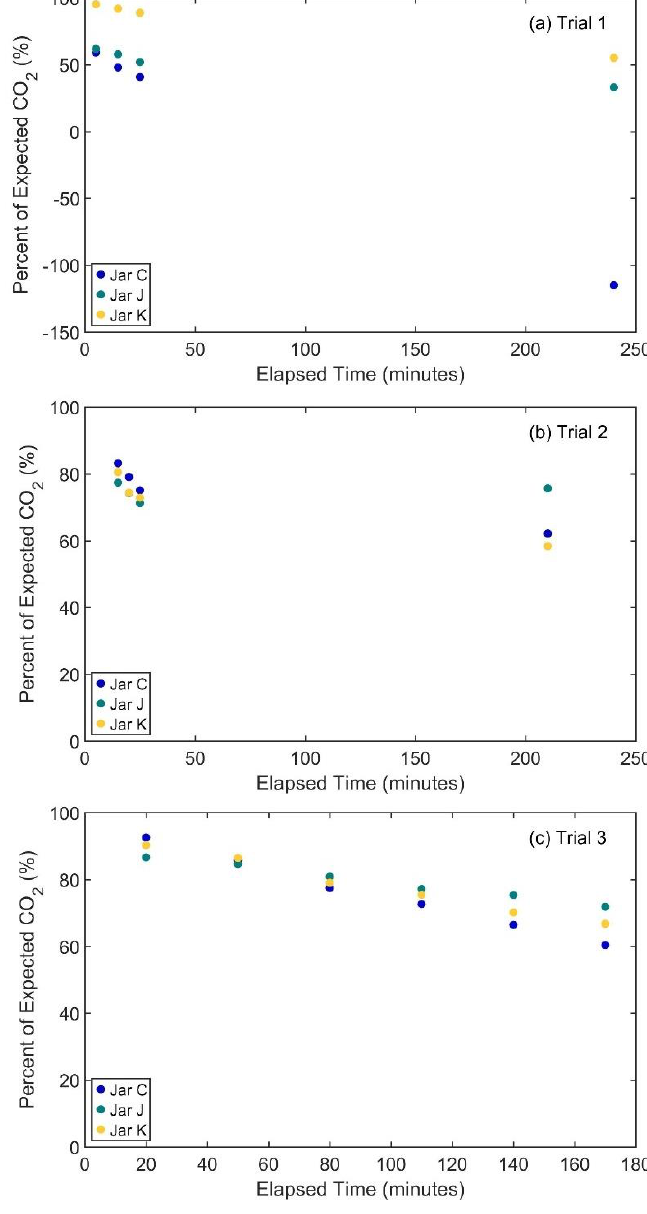
Figure 2. Plots of the three trials ( a – c ) performed to determine the incubation time needed for the carbonate present on the quartz filters to react with 1 M HCl and form CO 2 . In all three trials, the first measurement taken had the highest concentration of measured CO 2 .